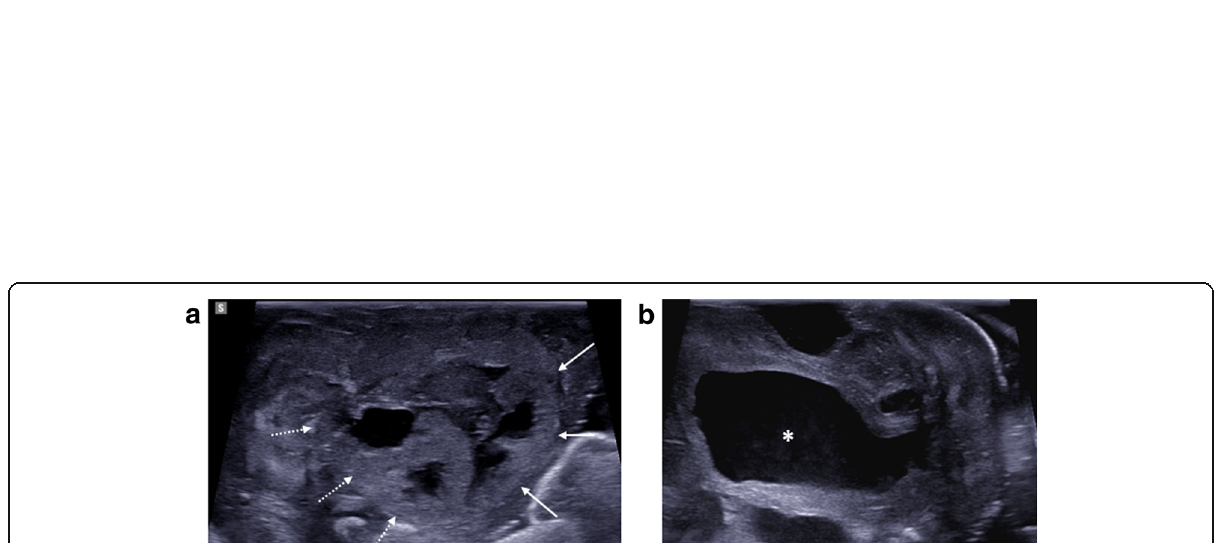
Fig. 21 Solitary left pelvic kidney in a foetus at 20 weeks gestation, following termination of pregnancy for presumed renal aplasia. Post-mortem imaging was obtained 3 days after delivery. Transverse post-mortem ultrasound image ( a ) demonstrates a soft tissue mass in the left iliac fossa which lacks the normal expected renal corticomedullary differentiation but appears to have a demonstrable hilum (solid arrow). The same finding is demonstrated on the corresponding post-mortem T2 weighted MRI study, obtained in axial plane ( b ) and also on photographs obtained at autopsy ( c ), acquired after careful dissection of the anterior abdominal wall. The extracted soft tissue mass ( d ) was confirmed to be renal in origin